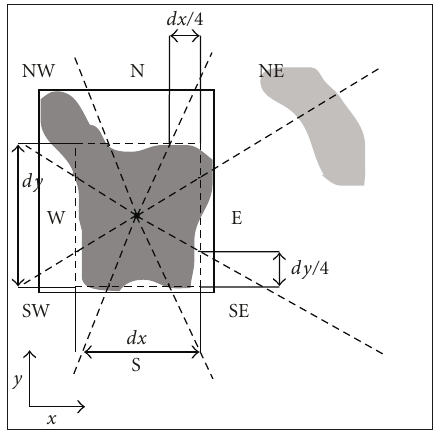
Figure 3: Fuzzy directional relations